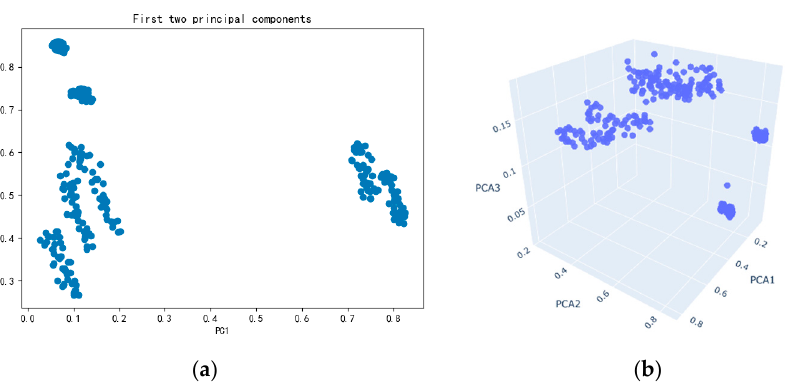
Figure 4. Scatter diagram of the vibration spectrum. ( a ) Two-dimensional scatter plot. ( b ) Three- dimensional scatter plot.